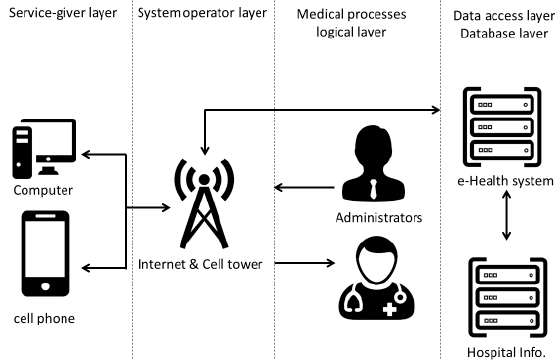
Figure 1. The schematic diagram of e-Health [9].